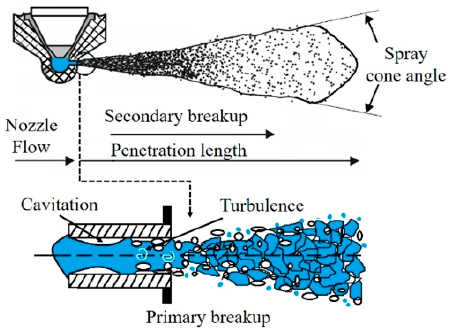
Figure 1. Full conical spray structure of a fuel jet.